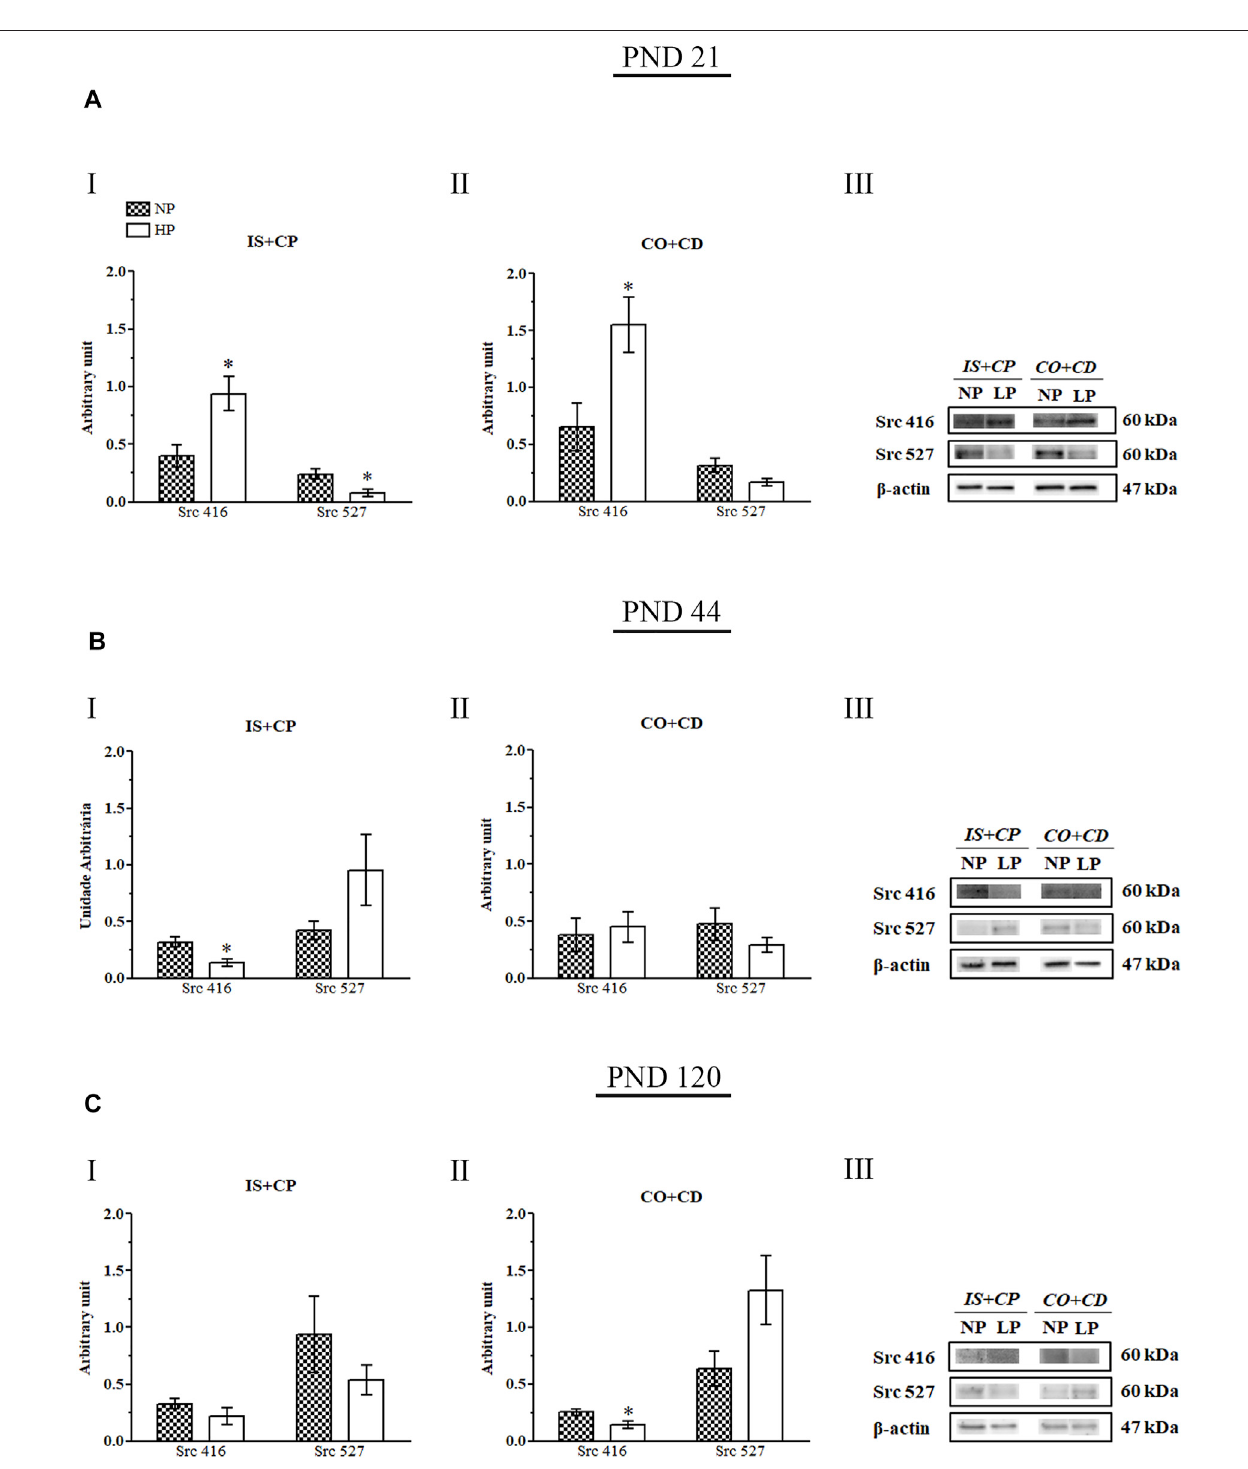
FIGURE8| ImmunoblotsofSrc416andSrc527. (A) LevelsofSrc416andSrc527intheIS+CP (I) andCO+CD (II) epididymalregionsofNPandLPanimalson PND 21. Therepresentative blots showthe protein levels ofSrc 416,Src 527and β -actin (70 µgofprotein)in 21-day-old animals (III) . (B) Levels ofSrc416and Src527 in the IS+CP (I) and CO+ CD (II) epididymal regions ofNPand LP animals on PND 44. Therepresentative blots show theprotein levels ofSrc 416, Src527 and β -actin (70 µgofprotein)in44-day-oldanimals (III) . (C) LevelsofSrc416and Src527intheIS+CP (I) andCO+CD (II) epididymalregionsofNPandLPanimals onPND 120.TherepresentativeblotsshowtheproteinlevelsofSrc416,Src527and β -actin(70 µgofprotein)in120-day-oldanimals (III) .Thedataarepresentedasthemean± S.E.M. * p < 0.05, Mann-Whitney test.